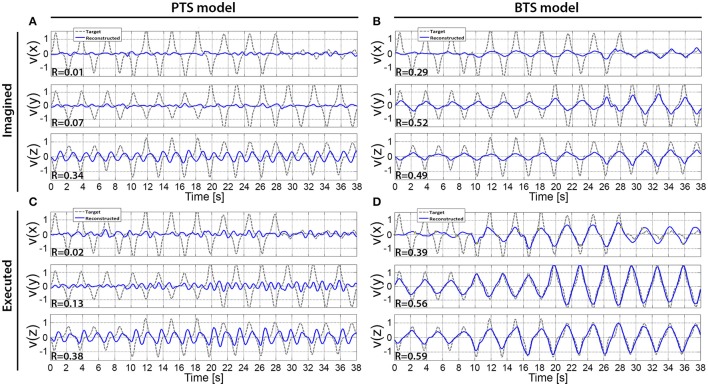
The cross-subject average of reconstructed hand velocity vector components. V(x), v(y), and v(z) velocity vector components are matching with executed or imagined movement in horizontal, vertical, and depth directions, respectively. For the imagined movement reconstruction (A,B), the target trajectory was calculated based on arm movement trials. The averaged trial of the imagined arm movement velocity reconstruction is presented in (A,B) for the PTS and BTS models, respectively. The averaged trial of executed arm movement velocity reconstruction is presented in (C,D) for the PTS and BTS models, respectively. The averaged trial for the PTS model (A,C) involve results of time-series predictions using the time-resolved low delta (0–2 Hz) band-pass filtered EEG. The averaged trial for the BTS model (B,D) involve results of time-series predictions using PSD of the optimal band selected in the inner level cross-validation [i.e., mu (8–12 Hz), lower beta (12–18 Hz), upper beta (18–28 Hz), and gamma (28–40 Hz) bands].